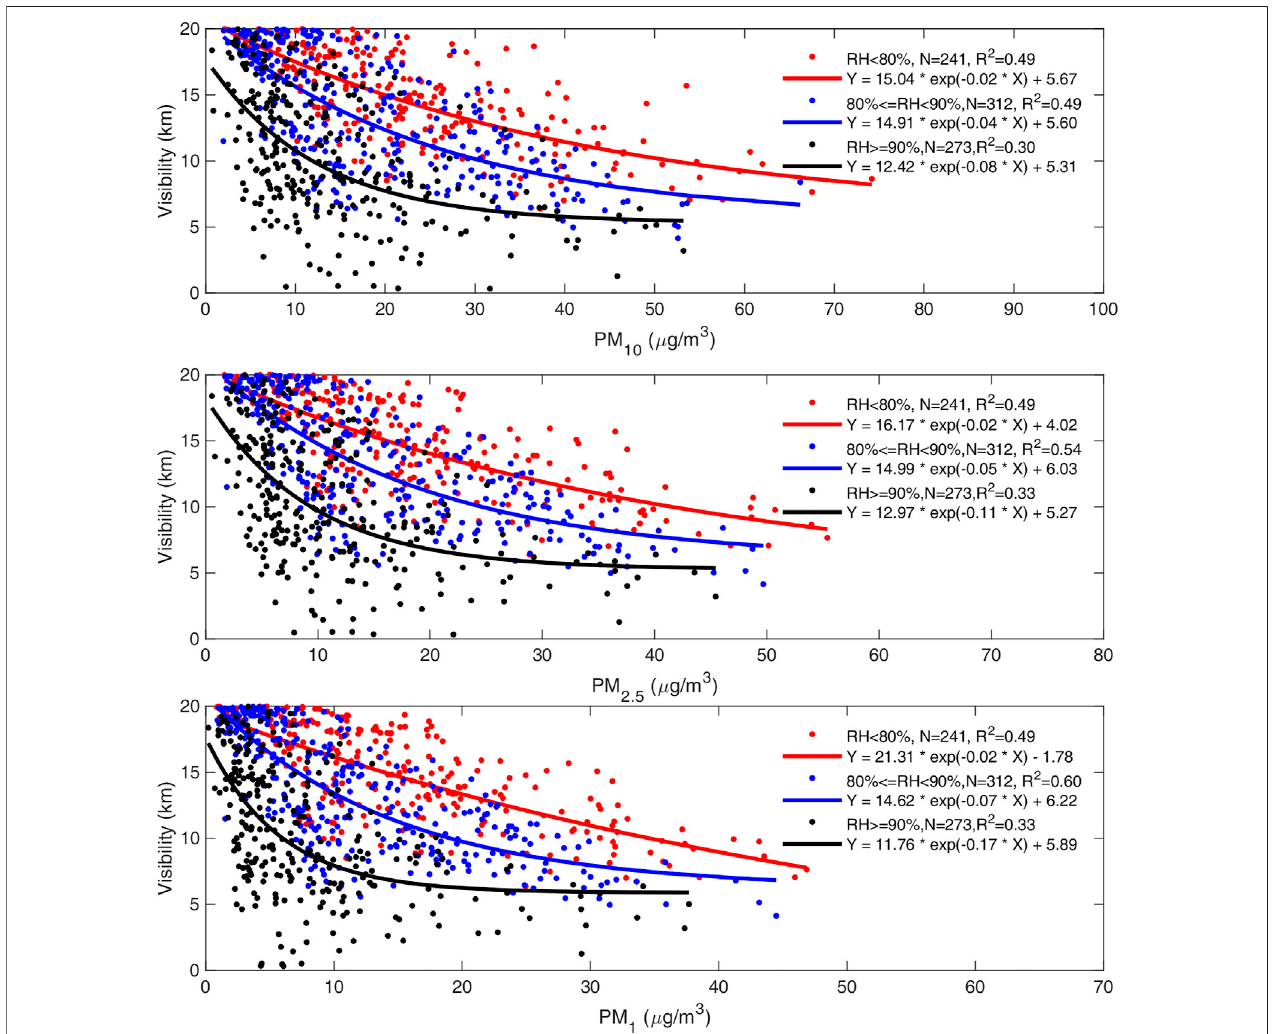
FIGURE 6 | The exponential function fi tting between visibility and PM mass concentrations in different RH ranges at Xichong.